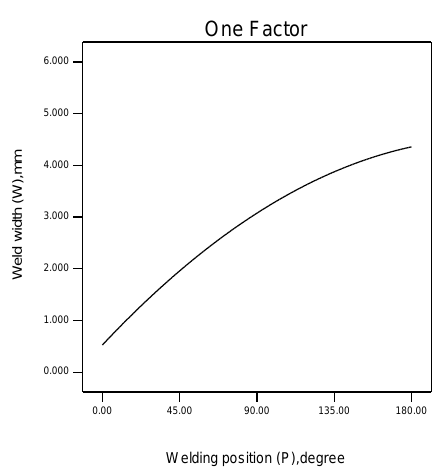
Figure 10. Influence of welding position on weld width.